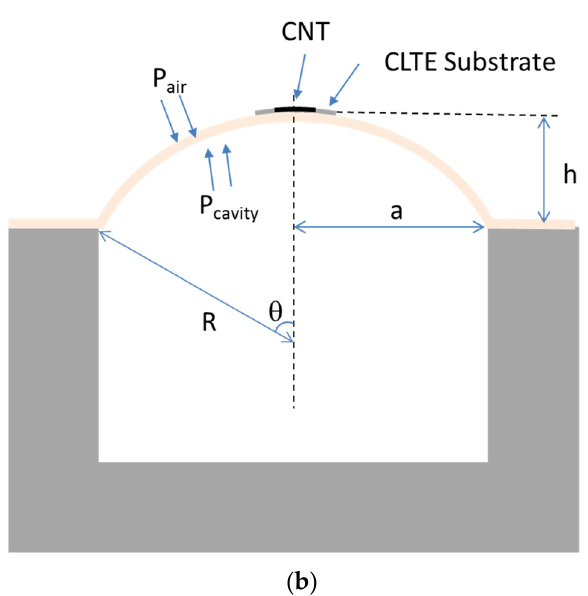
Figure 2. ( a ) Bulge test fixture; ( b ) schematic of geometry relationship for the bulge test.